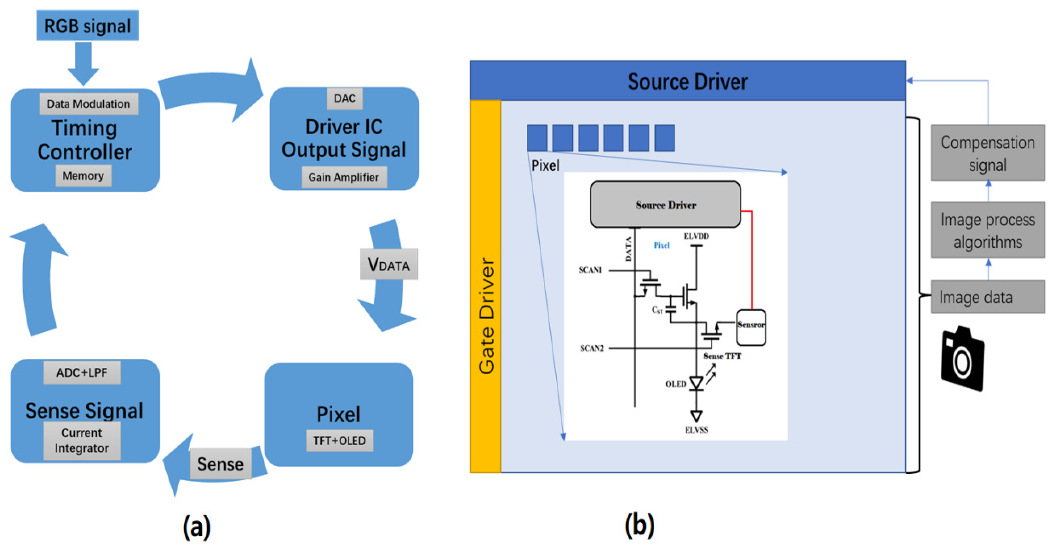
Figure 7. External compensation method: ( a ) Simplified block diagram. ( b ) External compensation approach.